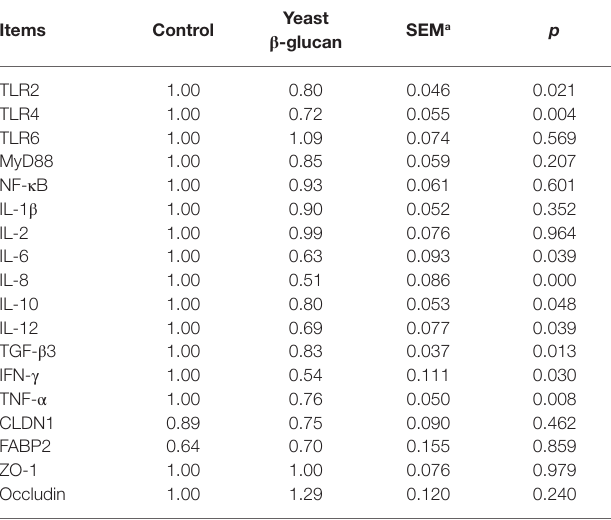
TABLE 2 | Effect of dietary yeast β -glucan supplementation on ileal mucosa gene expression in laying hens ( n = 8). Items